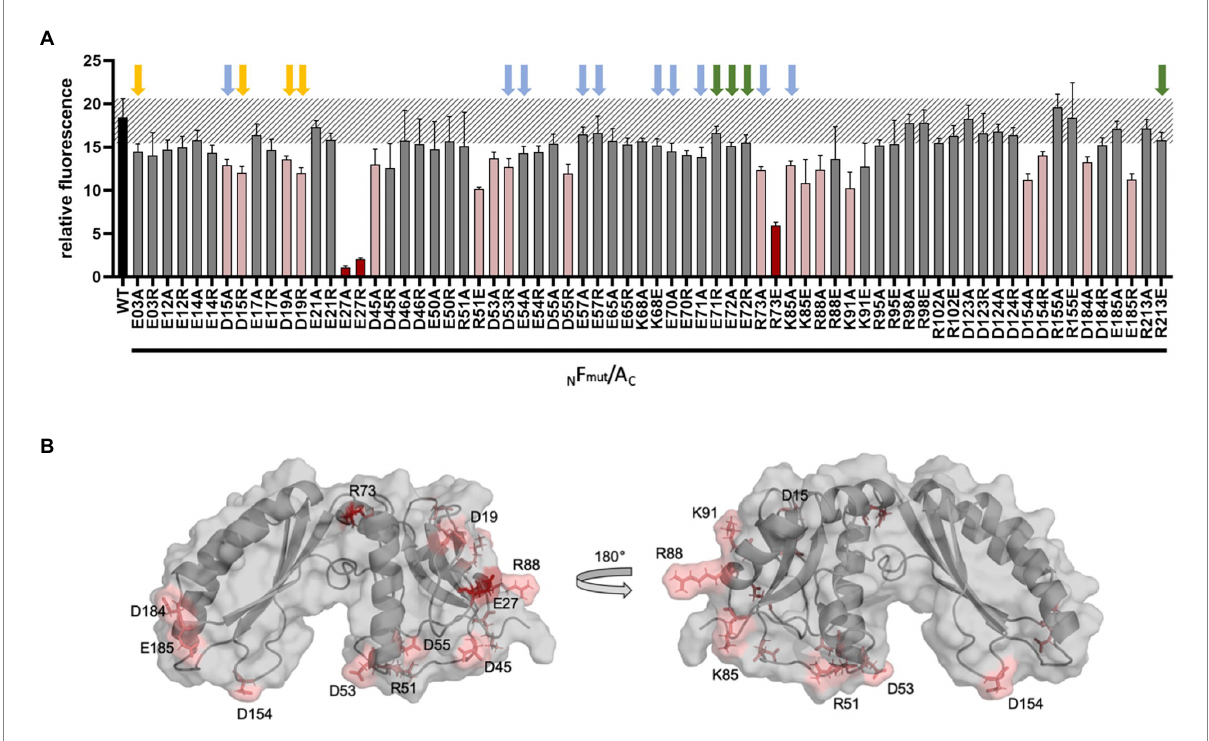
FIGURE 5 Split-GFP analysis of GvpF and of GvpF variants with GvpA. (A) The combination N F mut /A C contains NGFP fused to the N-terminus of GvpF and CGFP to the C-terminus of GvpA. The respective substitution present in Fmut is indicated at the bottom of the graph. The relative fluorescence is given in LAU/mm 2 , and only the combination with the highest rf value is presented. The relative fluorescence was calculated in relation to the fluorescence of Hfx. volcanii wild type. The error bars represent the standard deviation of the rf values of the biological/technical replicates. The relative fluorescence obtained with the GvpF wild type and GvpA (WT) is labeled in black; the standard deviation determined for this wild type interaction is marked in grey stripes. The GvpF variants resulting in a strong reduction of the fluorescence in F mut /A transformants are marked in red, and pink indicates F mut /A transformants resulting in a smaller reduction of the fluorescence (value of p red ≤ 0.001; pink ≤ 0.05). Three biological and three technical replicates ( n = 9) were performed in each case. Arrows above the graph indicate the presence or absence of gas vesicles in the respective ∆ F + F mut transformants. Colors used are: green, Vac − transformants; yellow, small gas vesicles; blue, cylinder-shaped gas vesicles (also see Supplementary Table S2). (B) Homology model of GvpF and location of the substitutions leading to a reduction of the F mut /A interaction. The aa substitutions leading to a strong reduction are indicated in red, and a less reduced fluorescence in pink. The homology modeling based on the crystal structure of GvpF of Microcystis aeruginosa (Yang et al., 2015) was done using I-TASSER